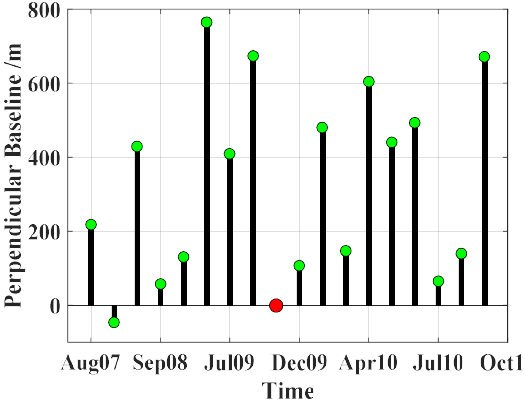
Figure 3. Interferograms processed by PSInSAR technique. The red dot denotes the master image. The black bars represent the pairs from which the interferograms were generated. The green dot denotes the slave image.